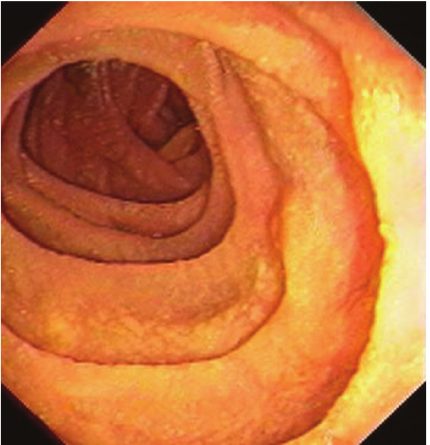
Figure 12: Whipple’s disease: control enteroscopy after one-year treatment. Morphology of jejunal folds has normalised, surface is stillrough,mucosahasfinegranularpattern,andsmallareasofgrey- yellowish colour still persist.